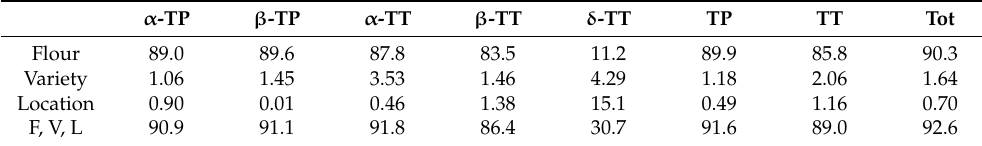
Table 1. Percentage of explanation (obtained through R-square from simple linear regression) of flour types (Flour; F), varieties (V), and growing locations (L) as well as their combinations on various tocols. α -TP β -TP α -TT β -TT δ -TT TP TT